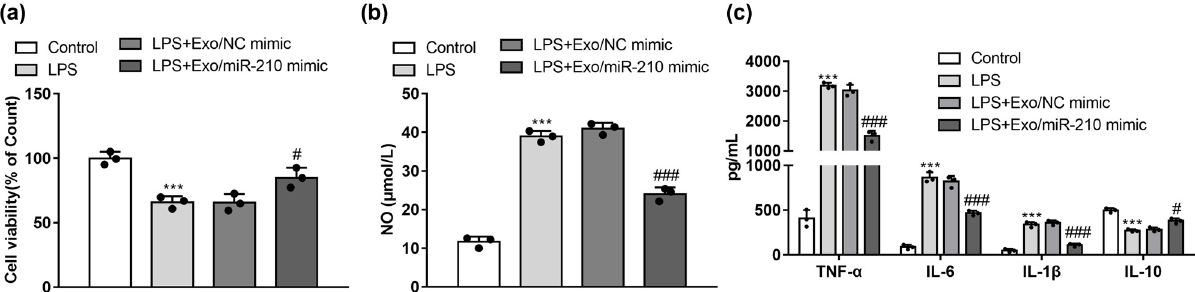
Figure 3: Exosomal miR - 210 inhibited LPS - induced NO production and the secretion of pro - in fl ammatory cytokines. Microglia were sti - mulated with LPS, followed by Exo/NC mimic or Exo/miR - 210 mimic. ( a ) Viability of microglia assessed using the CCK ‐ 8 method ( n = 3 ) . ( b ) NO assay in the supernatant of microglia ( n = 3 ) . ( c ) Concentrations of TNF - α , IL - 6, IL - 1 β , and IL - 10 were determined by ELISA analysis ( n = 3 ) . *** P < 0.001 vs Control; #P < 0.05, ### P < 0.001 vs LPS + Exo/NC